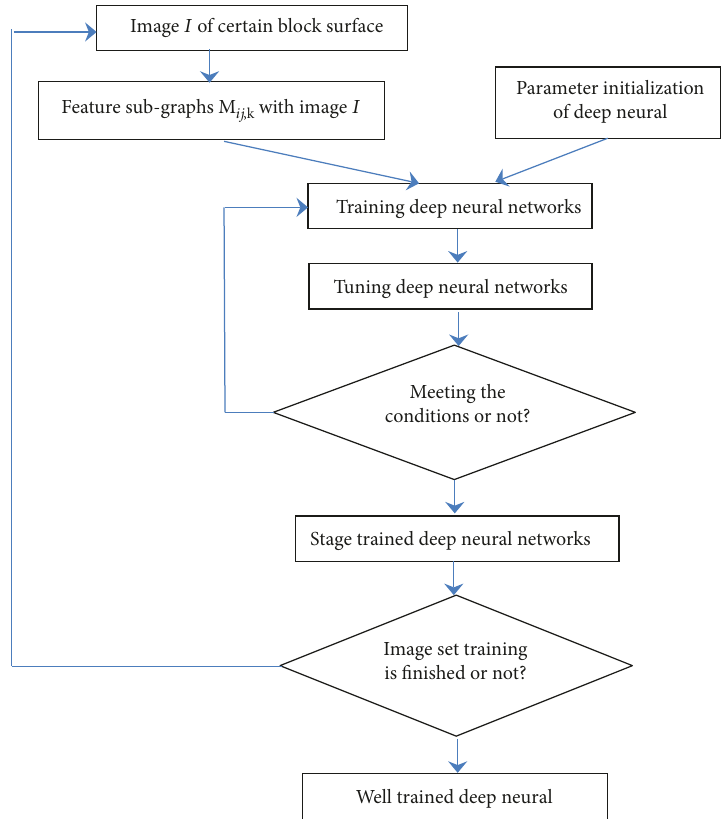
Figure 10: The process of generating the deep neural networks.